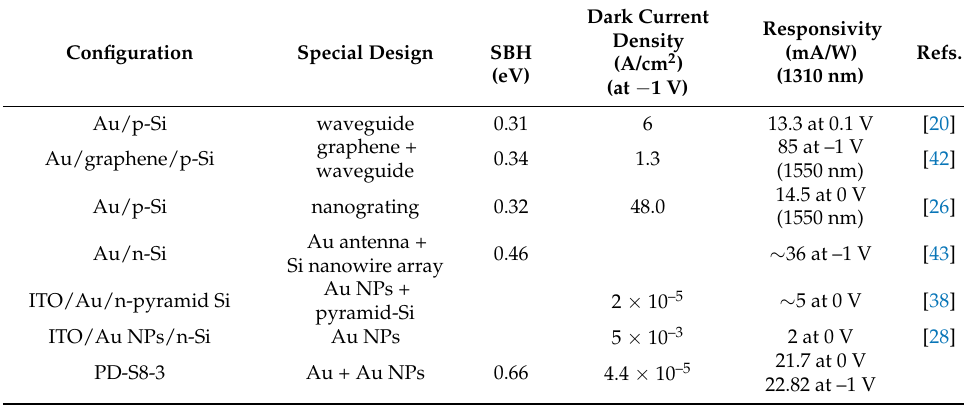
Table 2. Performance comparison for Si-based plasmon-enhanced (Au)